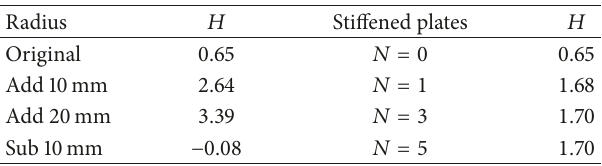
Table 3: The overall vibration isolation (changing geometries of the